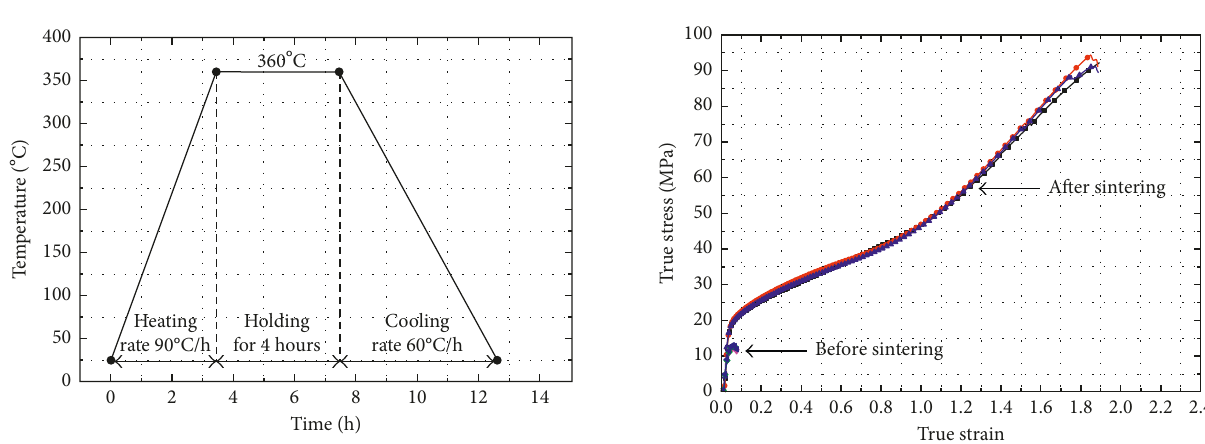
Figure 2: True stress-strain curves of specimen #2 before sintering and after sintering.